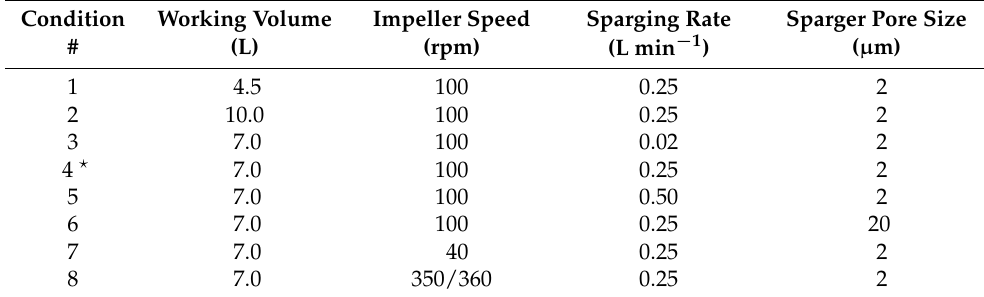
Table 1. Operating conditions, (cid:63) base case.